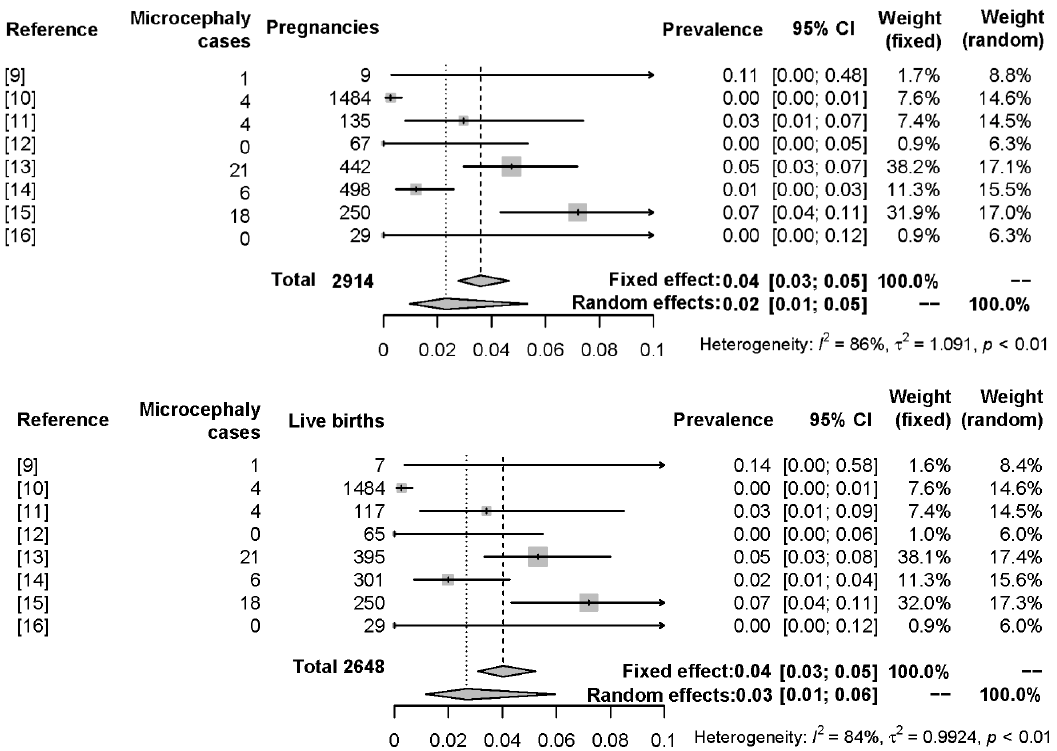
Figure 2 . Forest plot of the prevalence of the outcomes in the meta-analysis models 1 ( top ), which deals with the Zika virus-associated microcephaly prevalence among all pregnancies observed by the studies, and 2 ( bottom ), which deals with the Zika virus-associated microcephaly prevalence among live births only for the same studies. The plot displays pooled sample size (2914 pregnancies, model 1, or 2648 live births, model 2), individual prevalence estimates by each study, pooled prevalence estimate (fixed and random effects models), corresponding 95% confidence intervals, study weighting (fixed and random effects models), and heterogeneity measures.